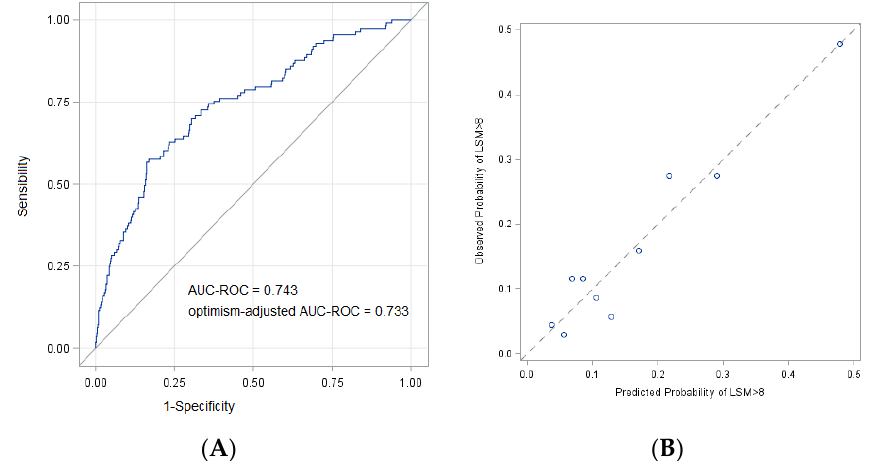
Figure 1. Performance of the prediction model for LSM ≥8 kPa in patients with NAFLD and FIB -4 < 1.3. ( A ): Receiver operating characteristic curve; ( B ): calibration plot displaying observed versus model-predicted probabilities across deciles of risk.